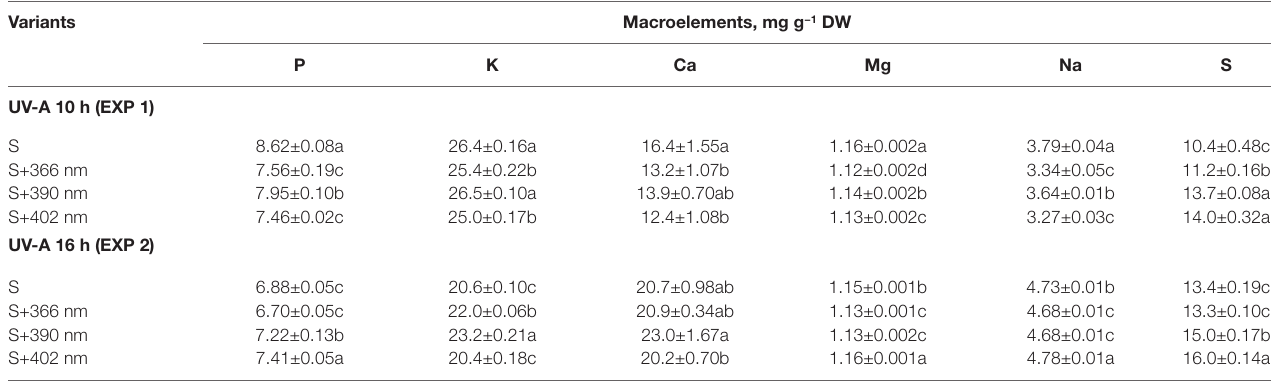
TABLE 2 | The effect of supplemental UV-A LED radiation on the macro elements of mustard microgreens. Variants